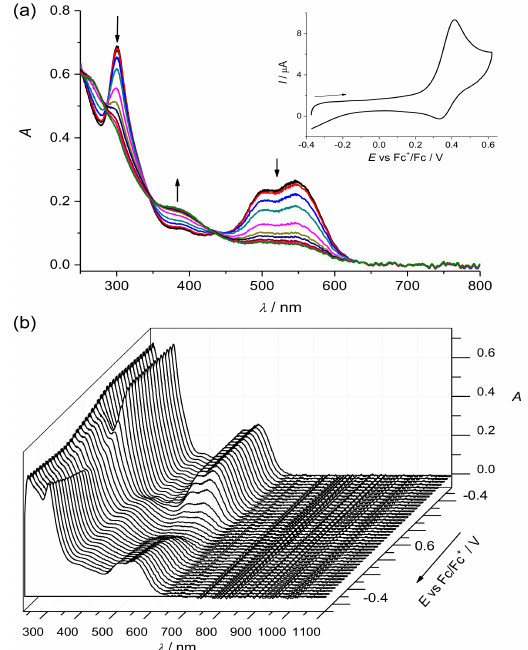
Figure 7. Evolution of UV-vis-NIR spectra in ( a ) 2D (forward scan, black trace: 0.15 V, red trace: 0.20 V, blue trace: 0.25 V, dark cyan trace: 0.30 V, magenta trace: 0.35 V, dark yellow trace: 0.40 V, navy trace: 0.45 V, wine trace: 0.50 V, pink trace: 0.55 V, olive trace: 0.60 V, all vs. Fc + /Fc) and ( b ) 3D projection during cyclic voltammetry (see the corresponding voltammogram in Inset of ( a ), scan rate 10 mV s − 1 ) of 14 in the region of the first oxidation peak in ACN/ n -Bu 4 NPF 6